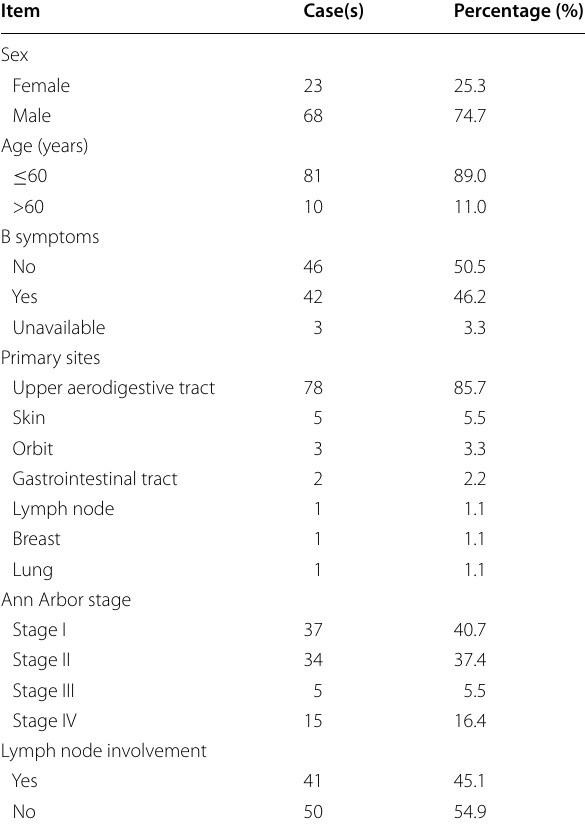
Table 3 Primary sites of 622 cases of mature T-cell and NK- cell lymphoma